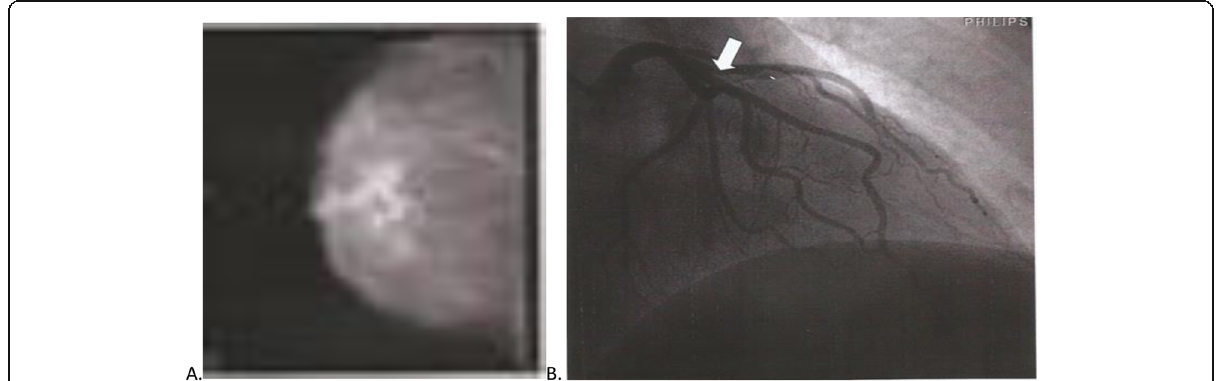
Fig. 4 49-year-old female patient known DM and chest pain on exertion and rest, cardiac catheterization revealed stenotic lesions at the proximal segment of left anterior descending artery. Bilateral breast mammography showing no BAC. b This is an example of CAD patient with no evidence of